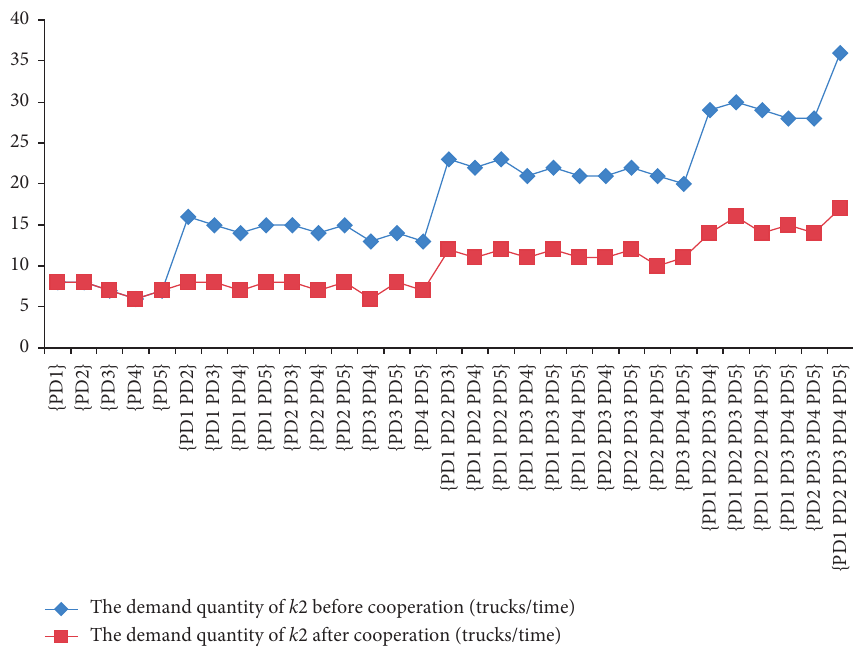
Figure 8: Comparison between initial and optimized networks k 2 usage